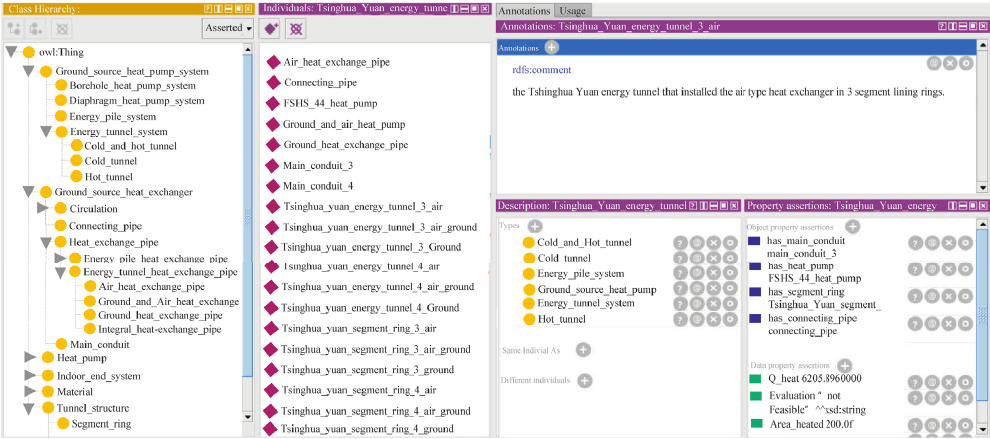
Figure 8: The inferencing interface of the OntoETS system.